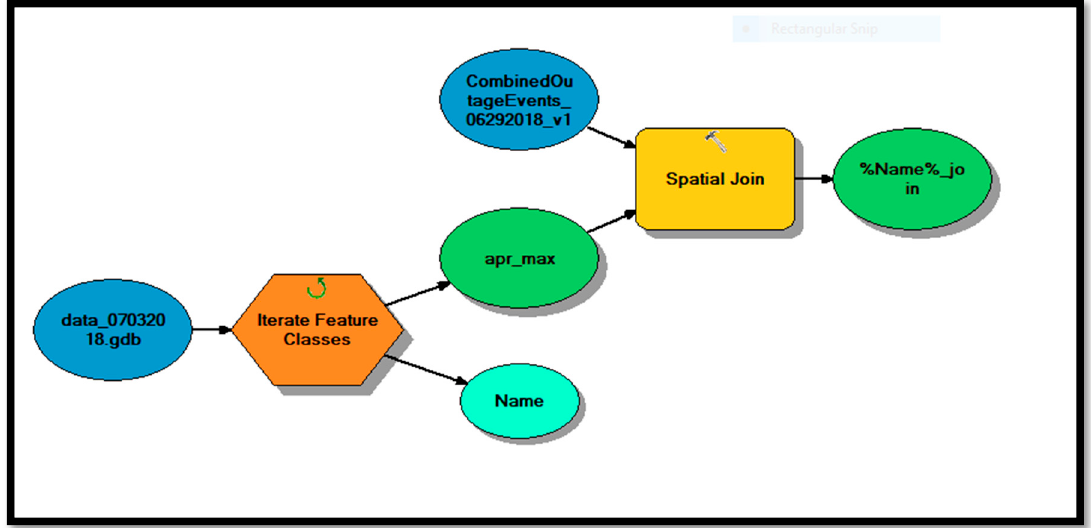
Figure 5. ArcMap ModelBuilder (Model 1) to spatially join the outage events with the weather data.